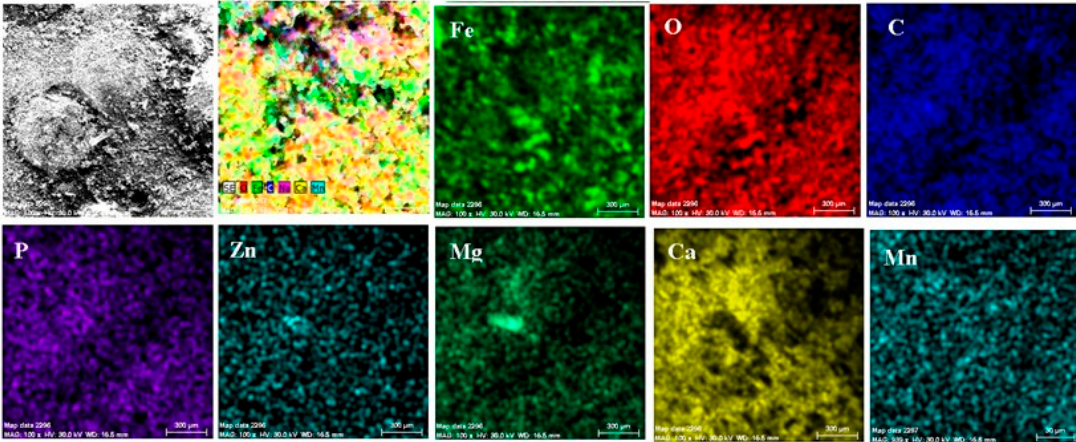
Figure 19. Elemental distribution in the crust on the PPS surface, after 78 days of immersion in seawater.